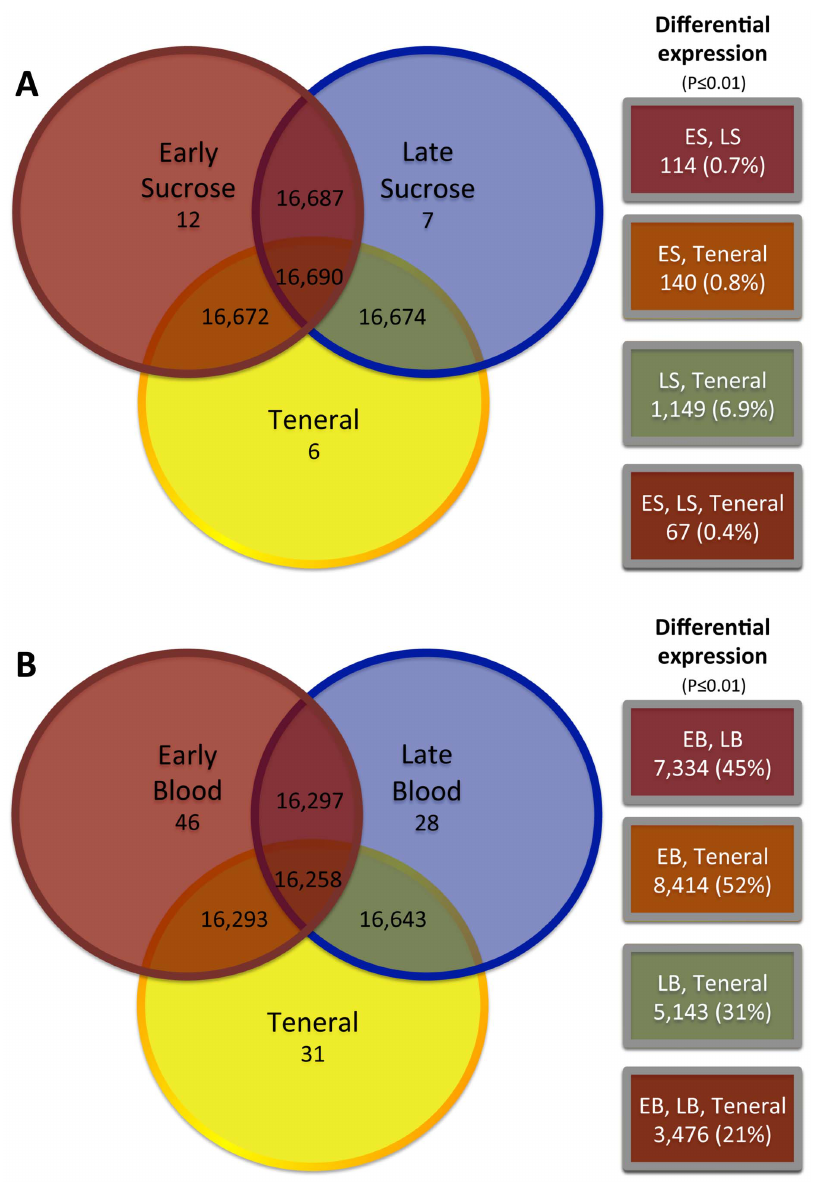
Figure 5. Transcriptome profiles and temporal expression analysis (early or late) within diet (sucrose or blood) in female Culicoides sonorensis . Comparison of the genes that were unique and shared between: A. teneral, early sucrose meal (2, 6, 12 h pooled; ES), and late sucrose meal (36 h; LS), or B. teneral, early blood meal (2, 6, 12 h pooled; EB), and late blood meal (36 h; LB). Right (boxes): The number of genes with differential expression profiles (P # 0.01), and the percent of shared unigene (in